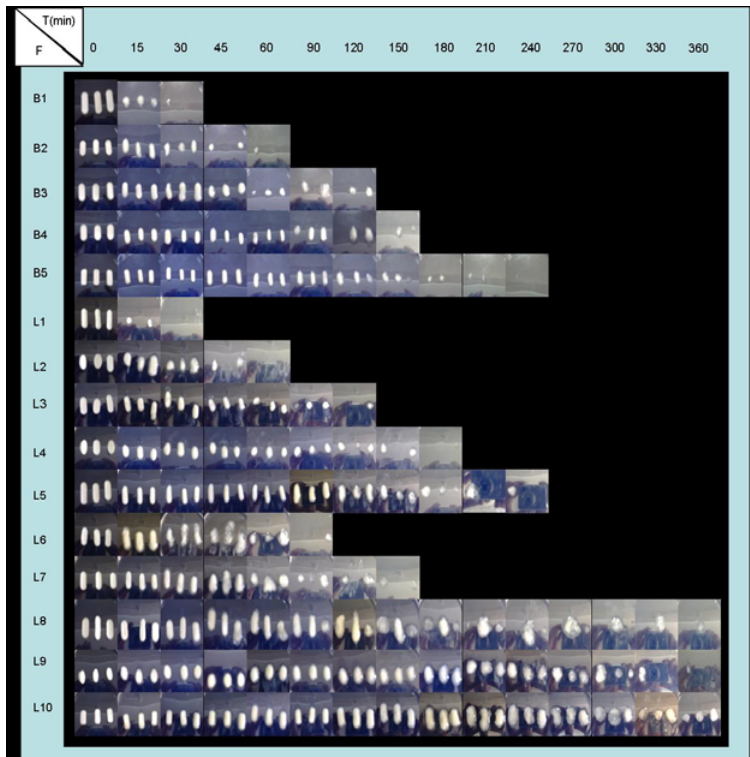
Figure 5. Appearance evolution of freeze-dried formulations (F) during swelling tests in progressive pH medium (1.5 → 4 →